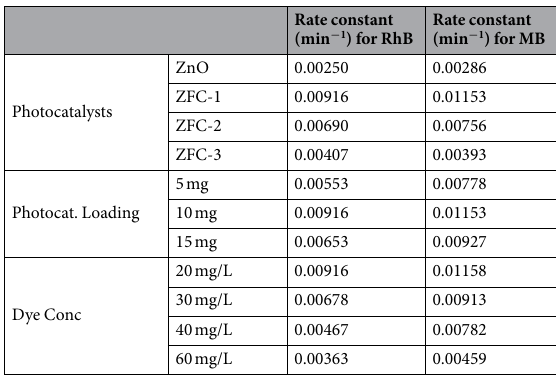
Table 1. Rate constants for both dyes with various